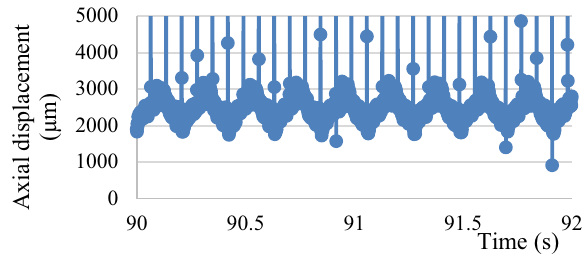
Fig. 18 Kick effects on rotary speed—kick region for